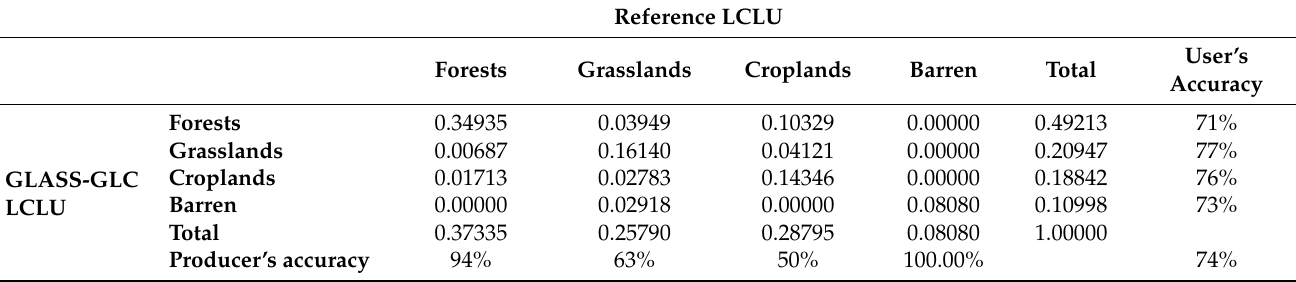
Table A3. Validation for GLASS-GLC LCLU in 2015 using very high-resolution imagery based on